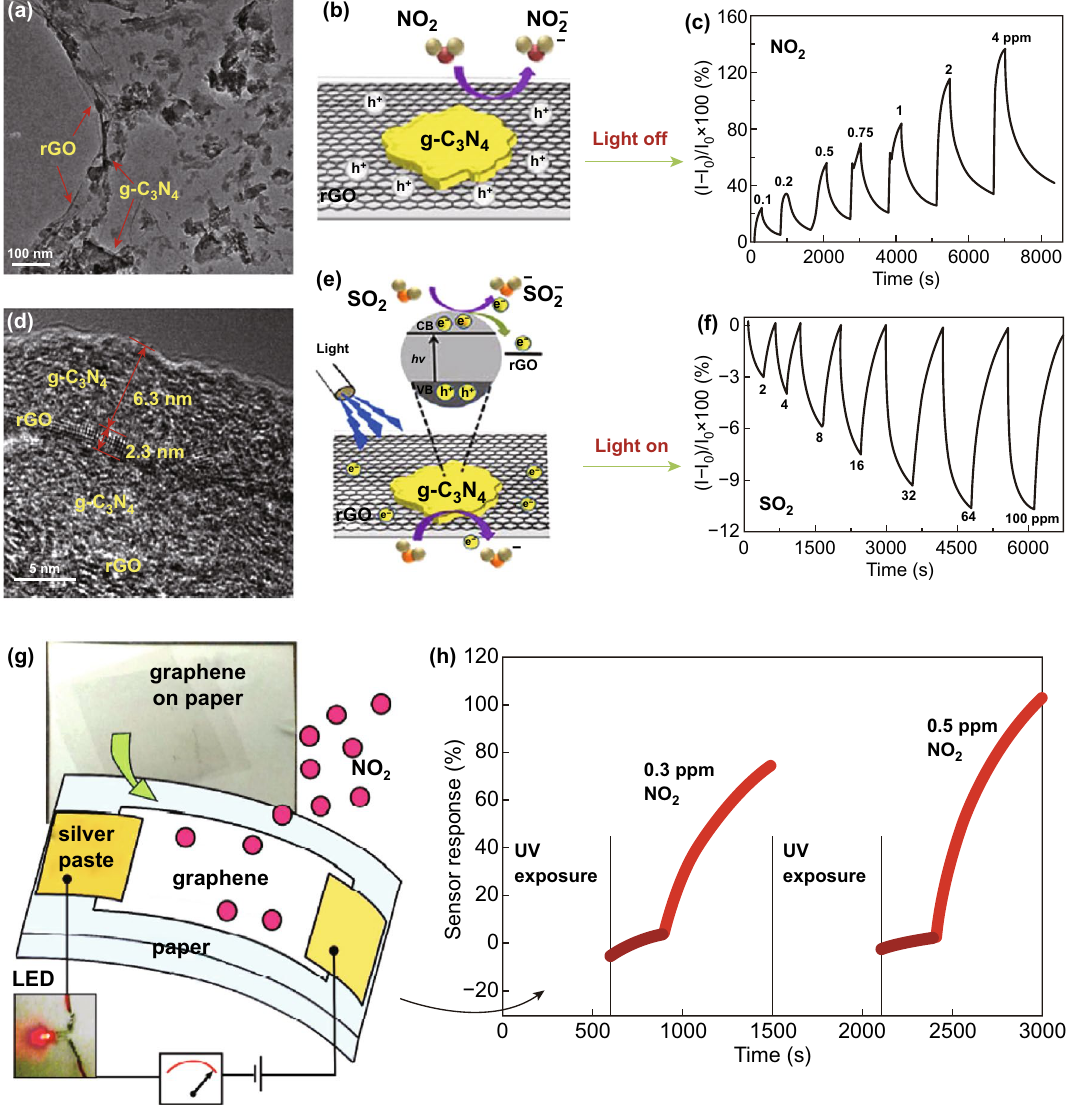
Fig. 11 SEM image of g-C 3 N 4 /rGO hybrid a in low, and d high magnification. b Schematic representation of charge transfer between g-C 3 N 4 / rGO hybrid and NO 2 under dark condition. c Transient gas response of the hybrid sensor to NO 2 gas under dark condition. e Schematic represen- tation of charge transfer between g-C 3 N 4 /rGO hybrid and SO 2 under UV light illumination. f Transient gas response of the hybrid sensor to SO 2 gas under UV light illumination. Reproduced with permission [103]. Copyright 2017, American Chemical Society. g Schematic illustration of a graphene sensor on paper substrate. h Gas response of the flexible graphene sensor. Reproduced with permission [104]. Copyright 2015,